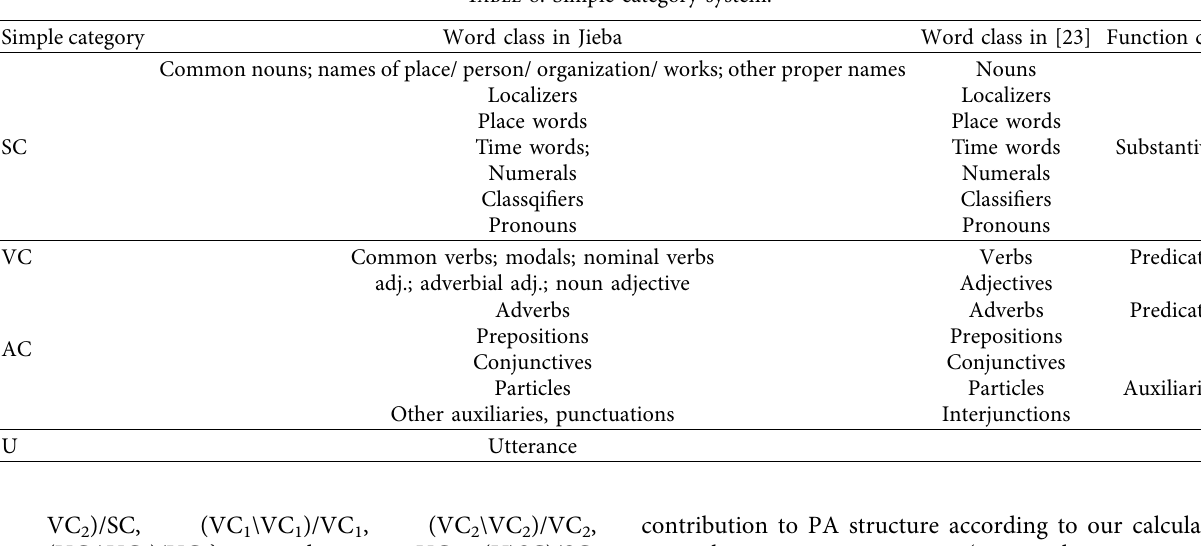
Table 8: Simple category